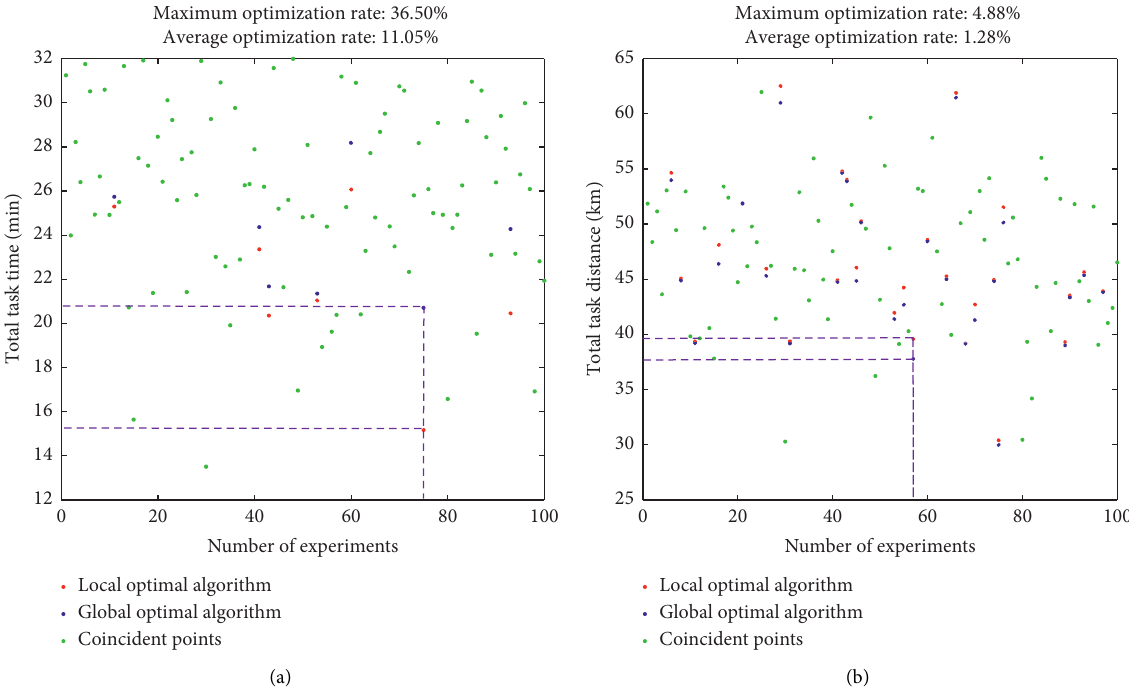
Figure 10: The results of two algorithms when R � 4km: (a) total task time of two algorithms; (b) total task distance of two algorithms. Maximum optimization rate: 36.50%; maximum optimization rate: